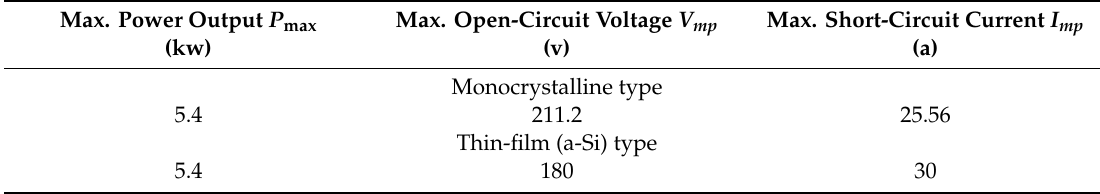
Table 5. Parameters of the PV model in fault-free